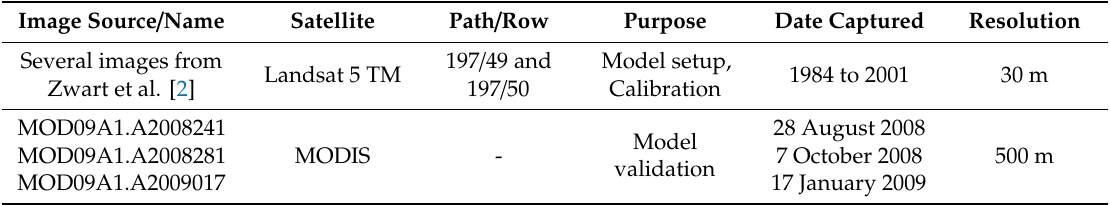
Table 1. Satellite images used in the study.